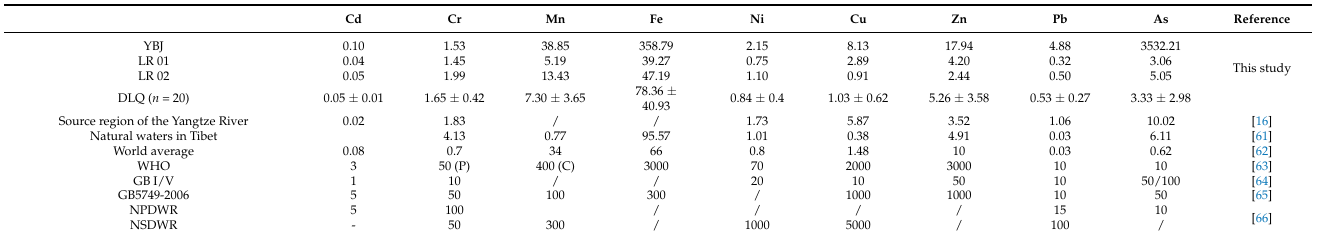
Table 3. Descriptive statistical results of heavy metals in surface water (mean ± standard deviation, µ